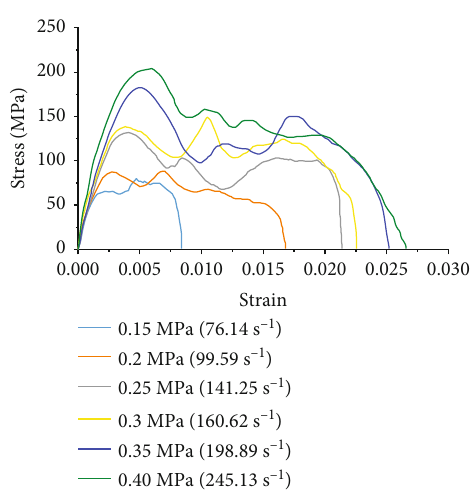
Figure 4: Stress-strain curves in the SHPB tests.